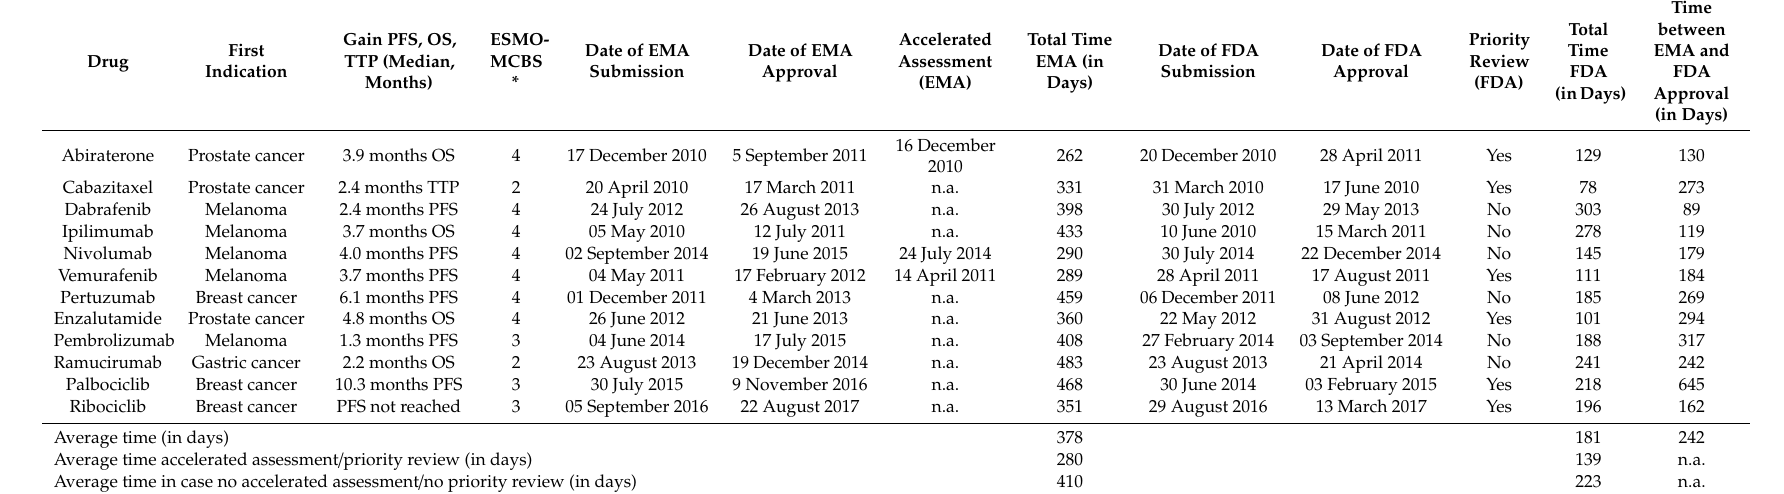
Table 1. Newly registered oncological drugs, first indications, clinical values, and duration of EMA and FDA